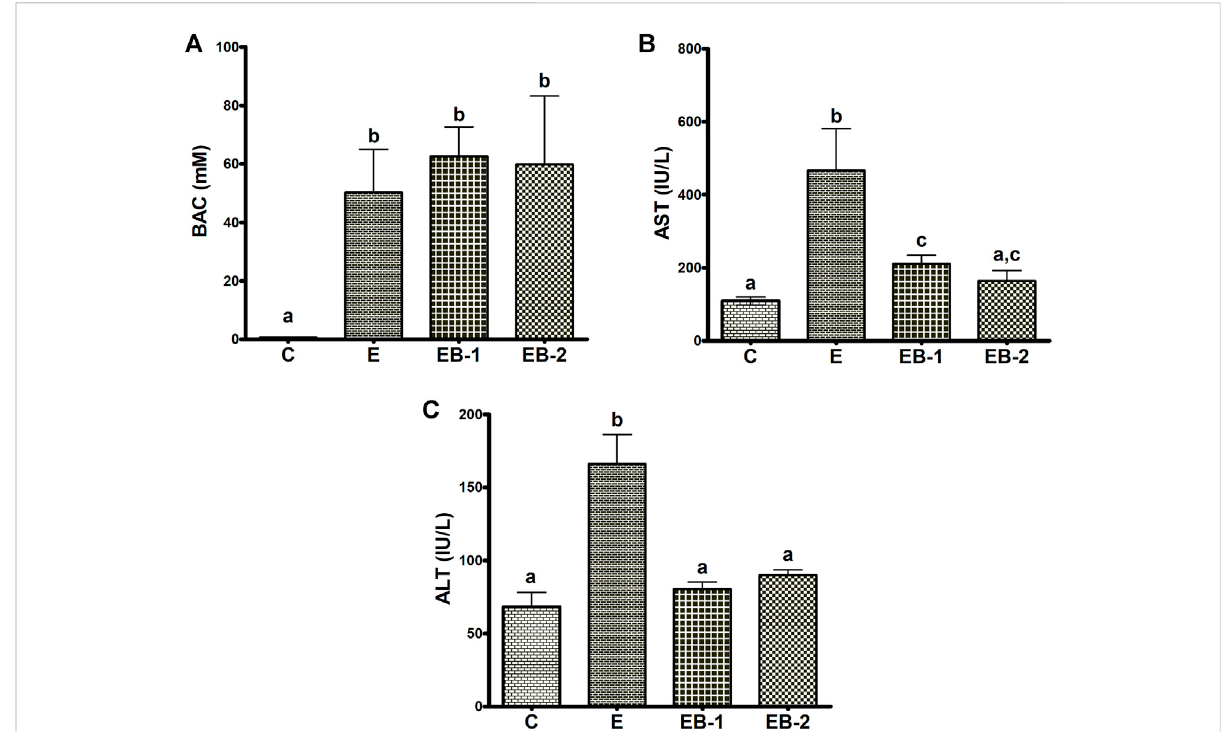
FIGURE 1 Blood alcohol, AST and ALT levels. (A) Serum blood alcohol concentration (BAC), (B) AST and (C) ALT levels in the livers of mice gavaged with saline [C], ethanol [E], or given betaine 2 h before [EB-1] or simultaneously with the ethanol binge [EB-2]. Data are presented as the mean ± SEM ( n = 5); values not sharing a common letter signi fi cantly differ from each other at p ≤